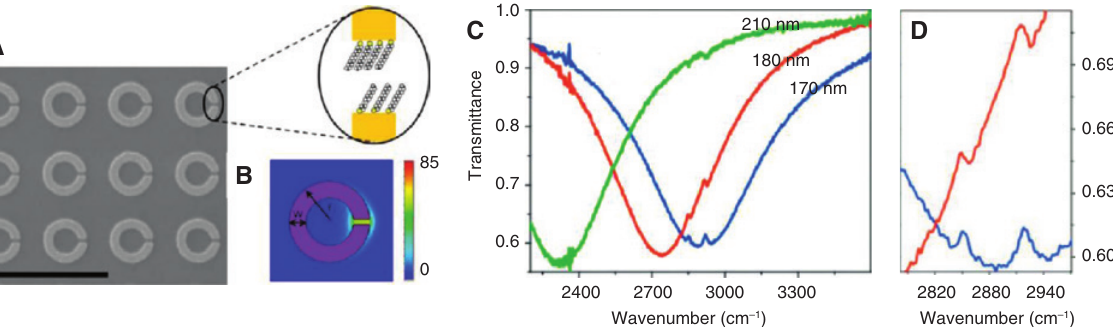
Figure 12: (A) Scanning electron micrograph of a typical SRR array. Scale bar is 1 μ m. Inset shows a schematic of a SAM of ODT molecules in the gap of a single SRR for absorption spectroscopy. (B) Simulated near-field amplitude distribution around a SRR on resonance for polari- zation along the gap. (C) Measured transmittance spectra for three different SRR arrays with radii 170 nm (blue), 180 nm (red), and 210 nm (green) with the SAM. Two peaks corresponding to ODT absorption are clearly visible. (D) Close-up view of the resonance region in (C). Adapted from Ref. [102], with the permission of AIP